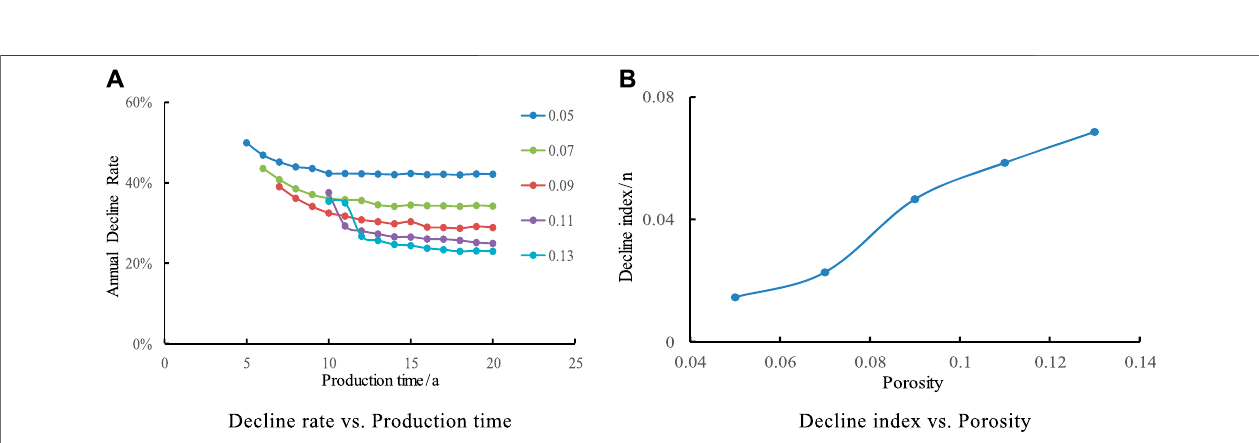
FIGURE 1 | Effect of Permeability on Annual Decline Rate and decline index. (A) Decline rate vs. Production time. (B) Decline index vs. Permeability.